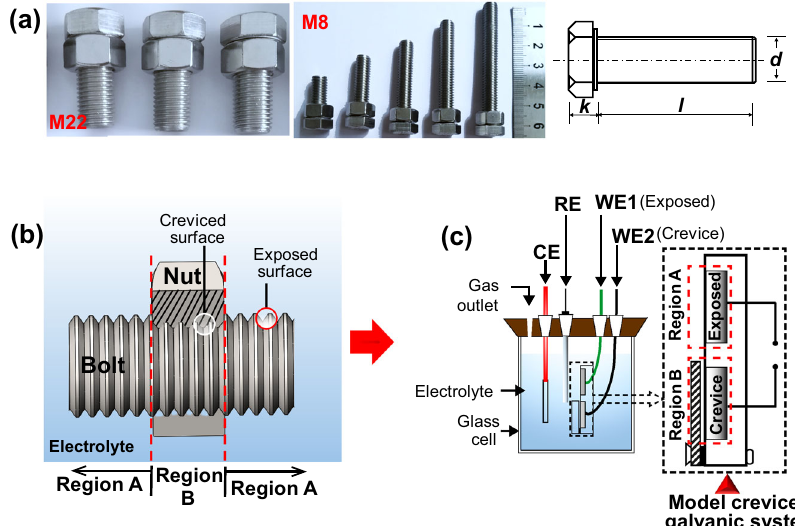
Fig. 10 Schematic representation of the test specimens and experimental set-up. a Pictures of the bolt and nut fasteners, b schematic illustration of the area of interest on the threaded fastener surface, c experimental model/electrochemical